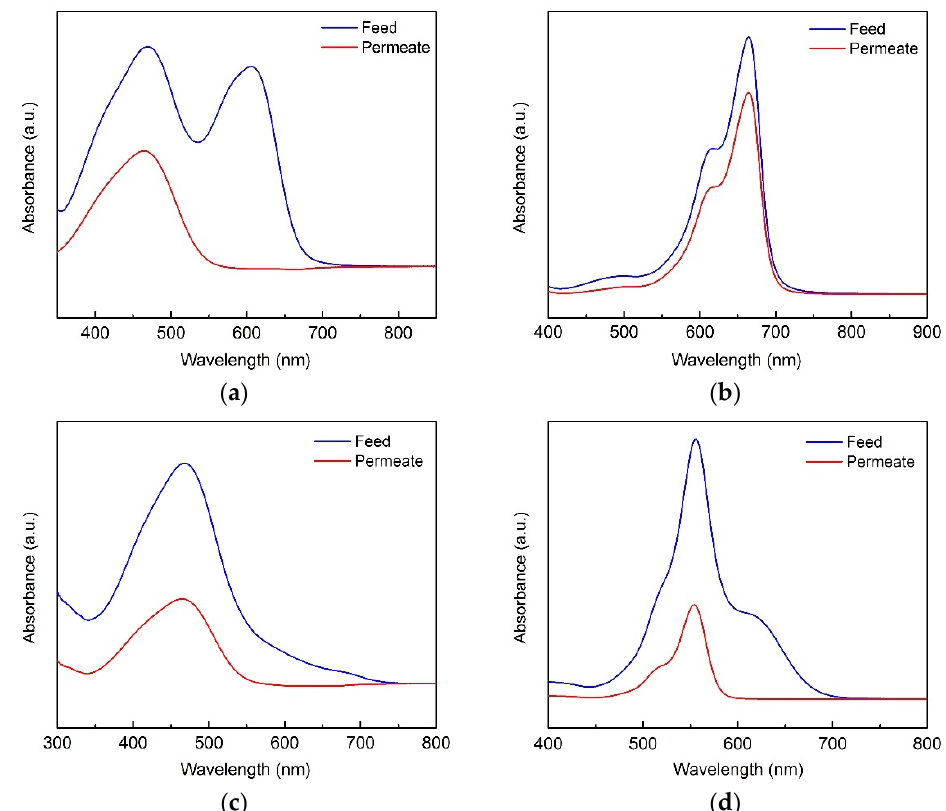
Figure 8. Absorbance spectra of the feed and permeate with binary dye mixtures of ( a ) EB/MO, ( b ) MB/CR, ( c ) EBT/MO, and ( d ) RhB/EB (preparation conditions: 0.1 g/L CoAl-LDH, 2 wt.% CNT; operating pressure: 0.1 MPa).